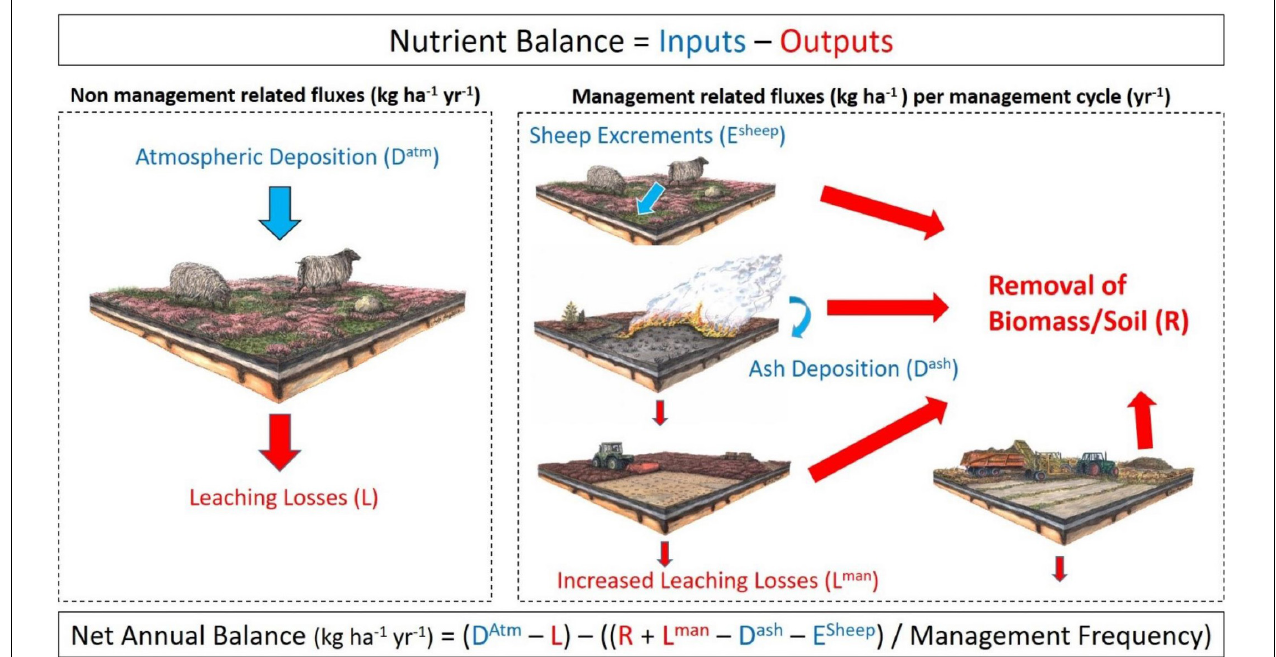
FIGURE 1 | Nutrient fluxes included in the calculation of nutrient balances. Drawings of management practices used with permission from Antje